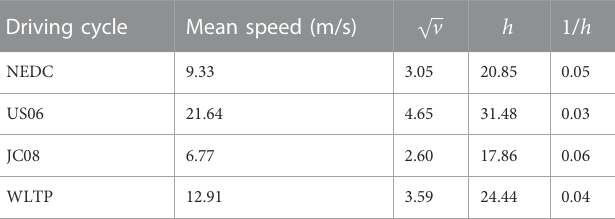
TABLE 2 Kinematic parameters for different driving